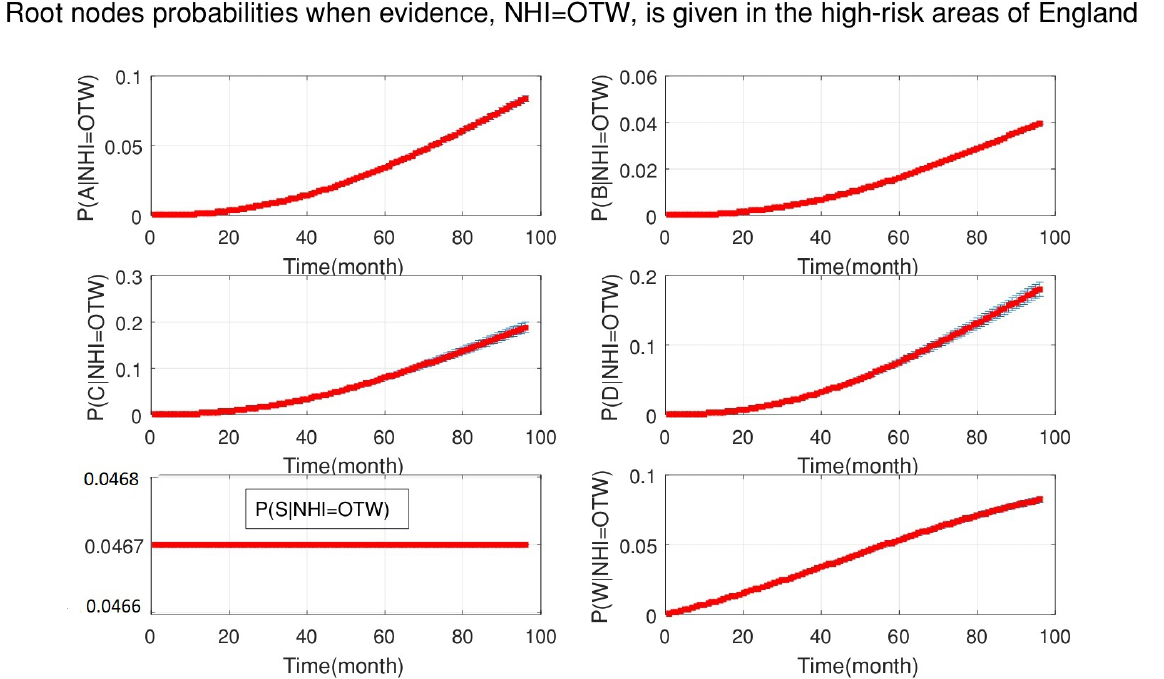
Figure 5. The probabilities of all root nodes (A is the age of cattle, B is the badger density, C is the manure storage, D is the stock density, S is the silage fed and W is the number of purchased cattle) when the evidence, officially TB free status withdrawn (OTW), is added to the system continuously from 2008 to 2015 (bottom-up inference for diagnosis).